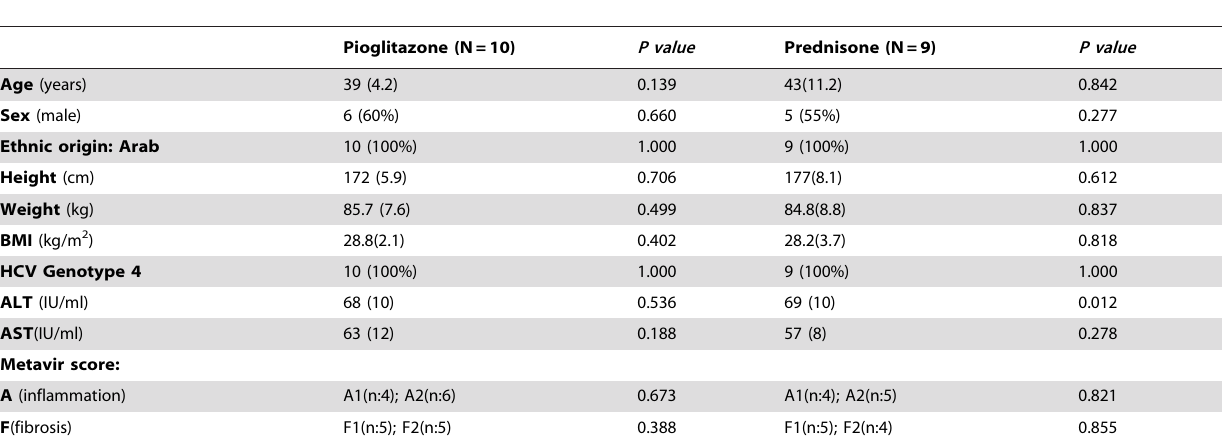
Table 2. Baseline demographic and clinical characteristics of non-treated